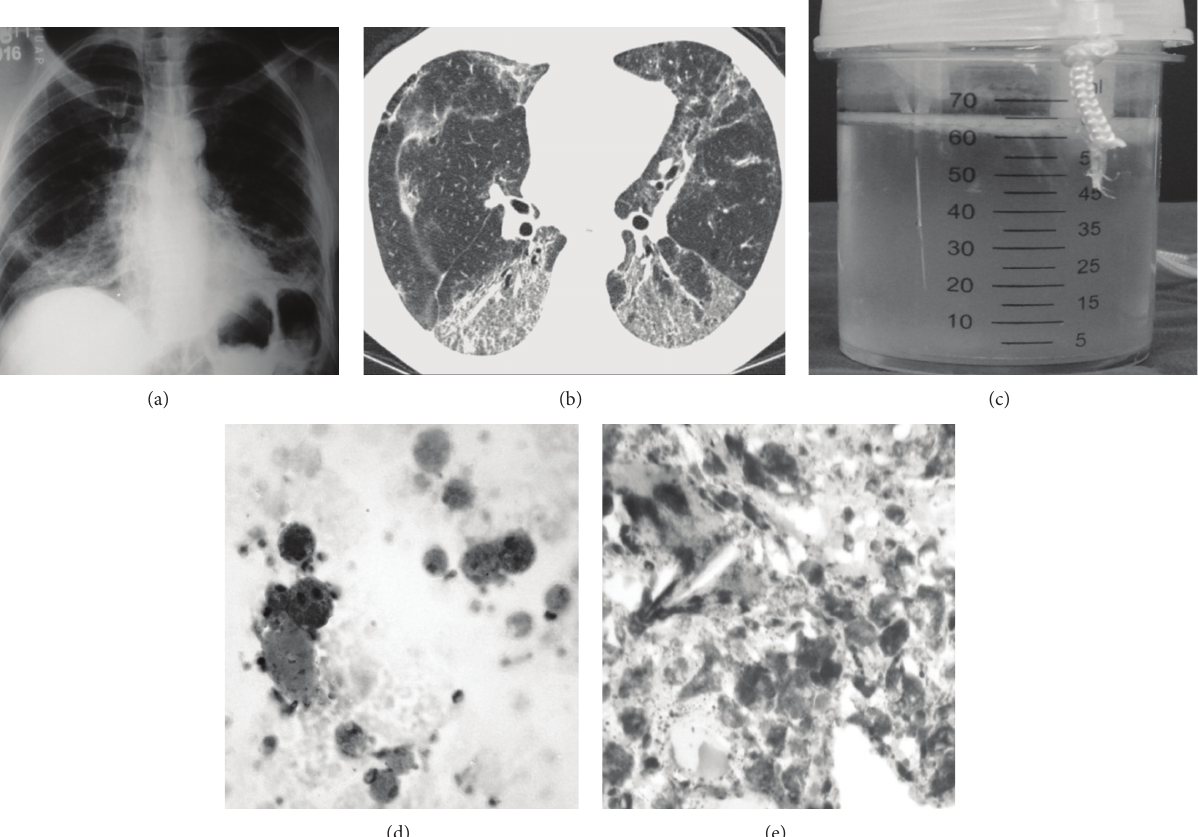
Figure 2: (a) PA chest radiograph: consolidations at lung bases. (b) Chest HRCT: nonhomogeneous consolidations, ground-glass opacities, areas of fibrosis with parenchymal beams, and bronchiectasis traction. (c) Segmental pulmonary lavage fluid: cloudy with halo of fatty supernatant. (d) Bronchoalveolar lavage fluid: presence of macrophages with foamy cytoplasm showing positive oil red O staining. (e) Histopathologic section of lung (oil red O, 400x) showing orange-colored lipid contents “lipid laden